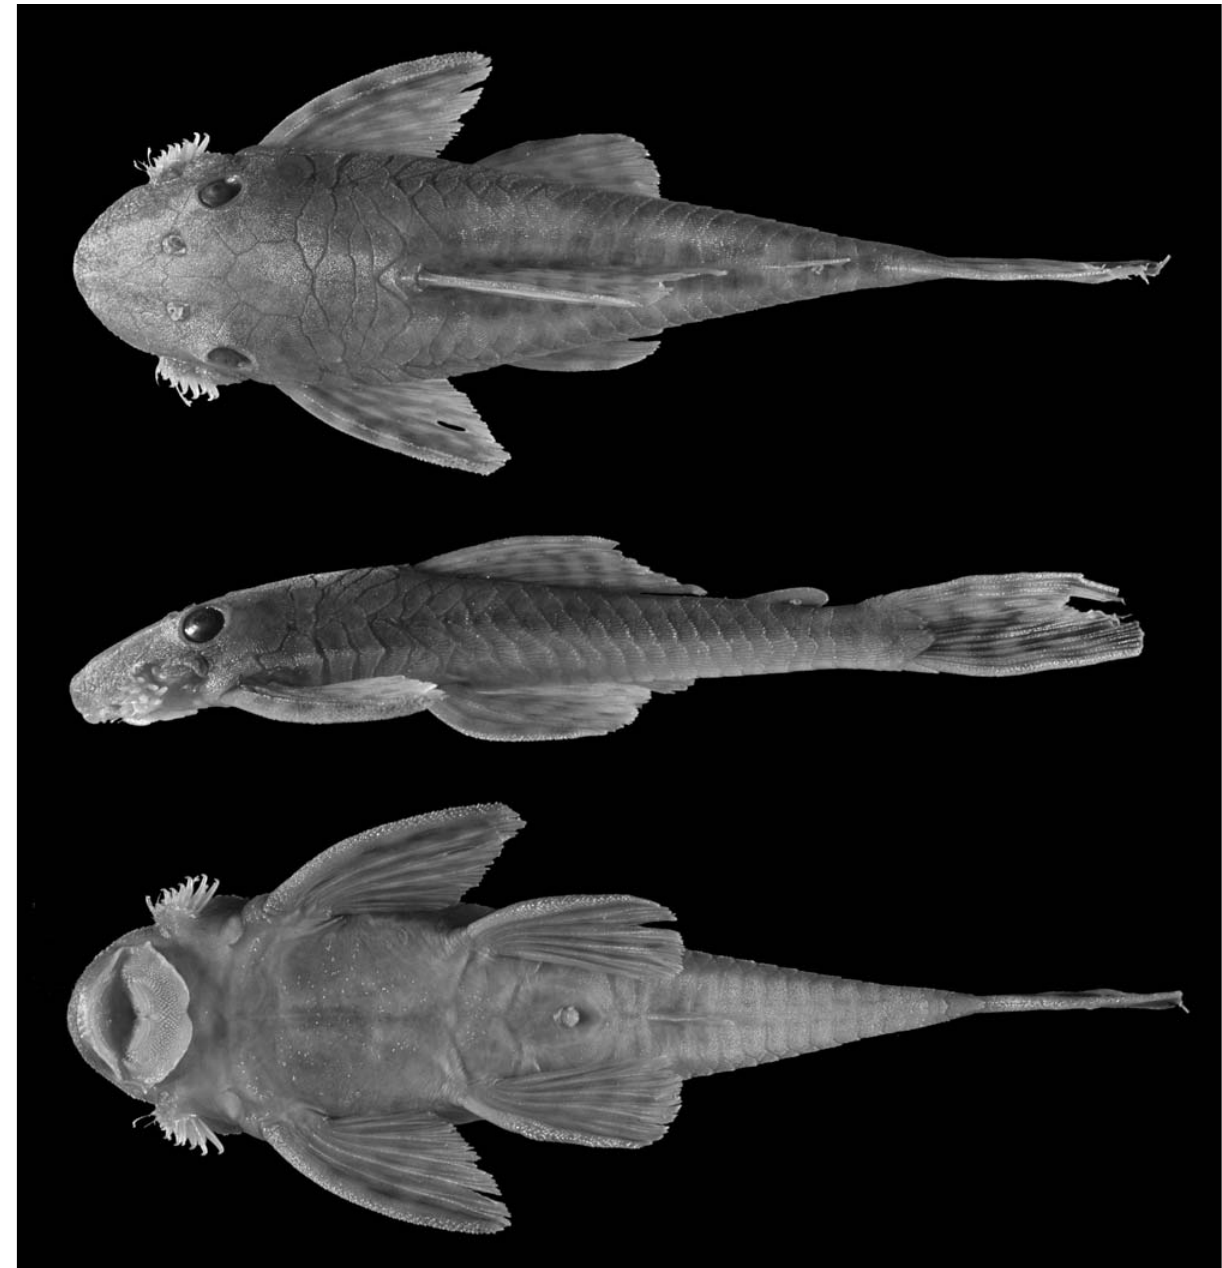
Fig. 6. Dorsal, lateral, and ventral views of Lasiancistrus heteracanthus , FMNH 111719, 108.3 mm